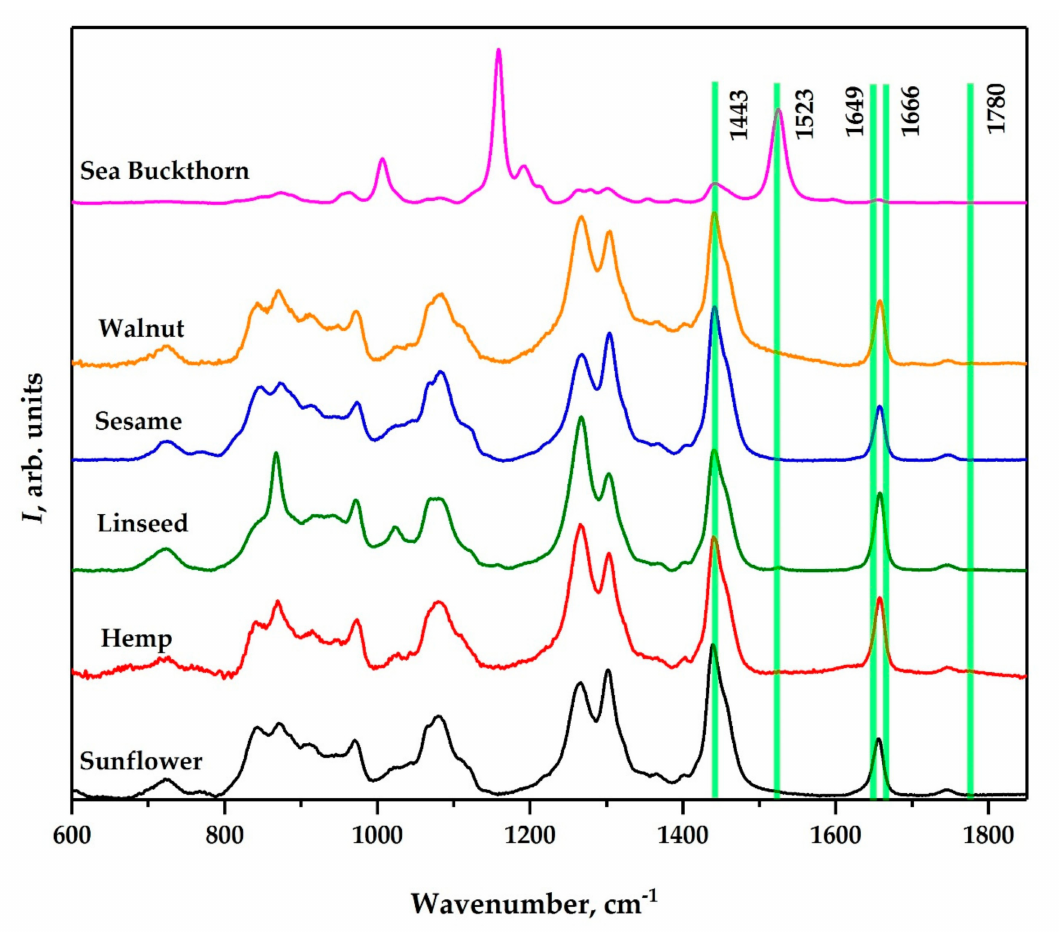
Figure 3. Raman spectra for the six types of oils with the main marker bands employed for the simultaneous